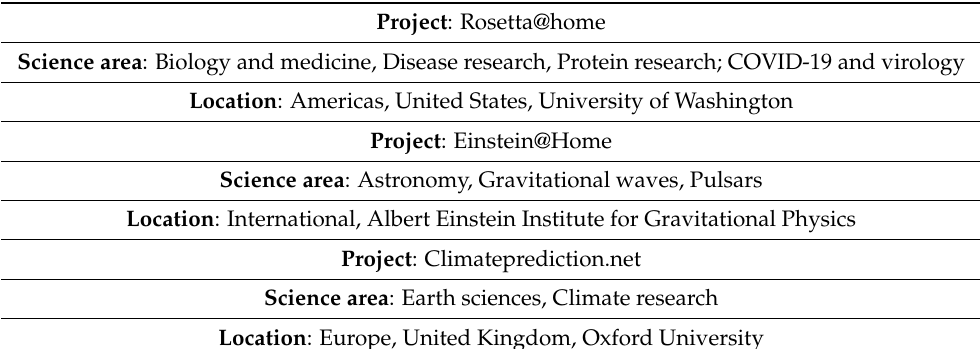
Table 1. Examples of BOINC projects and their keywords.